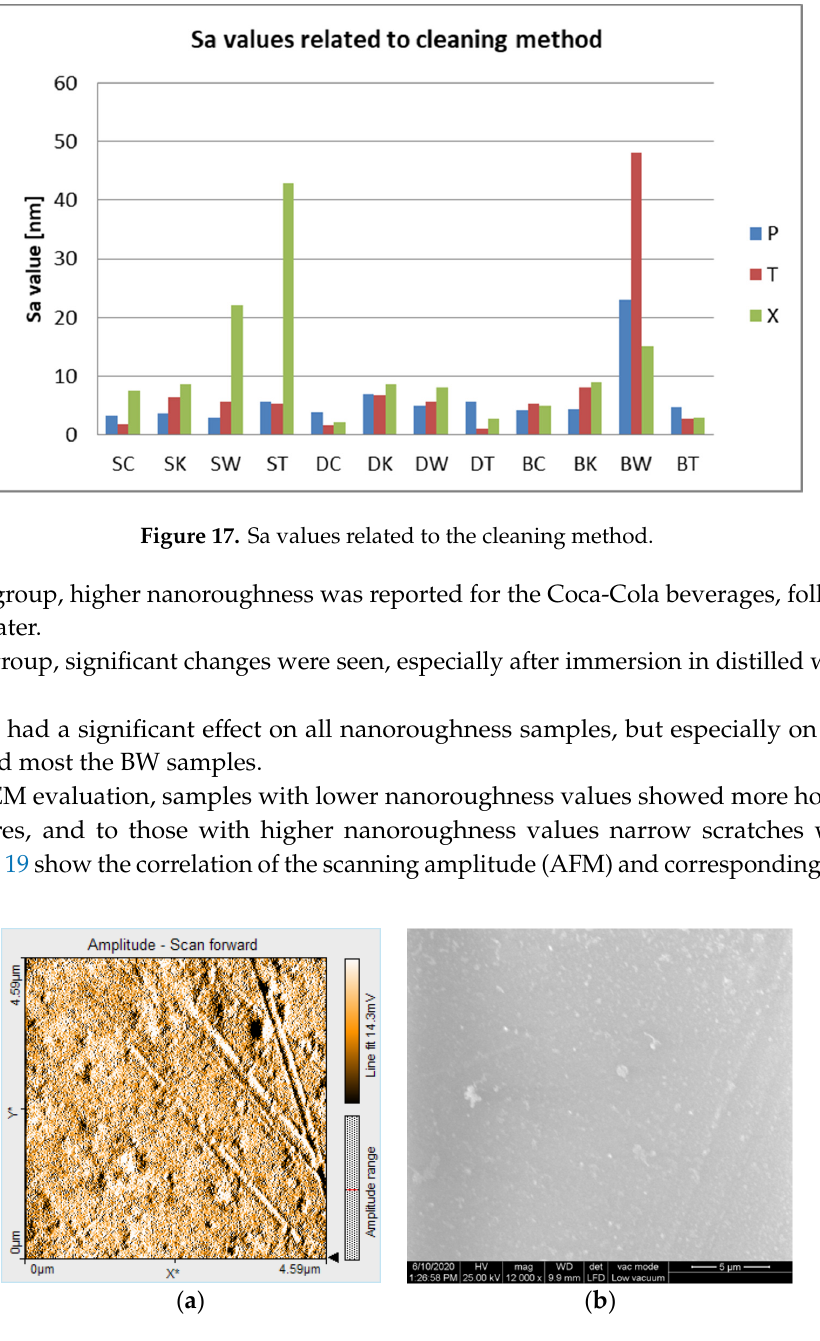
Figure 16. Sa values related to the immersion beverage.